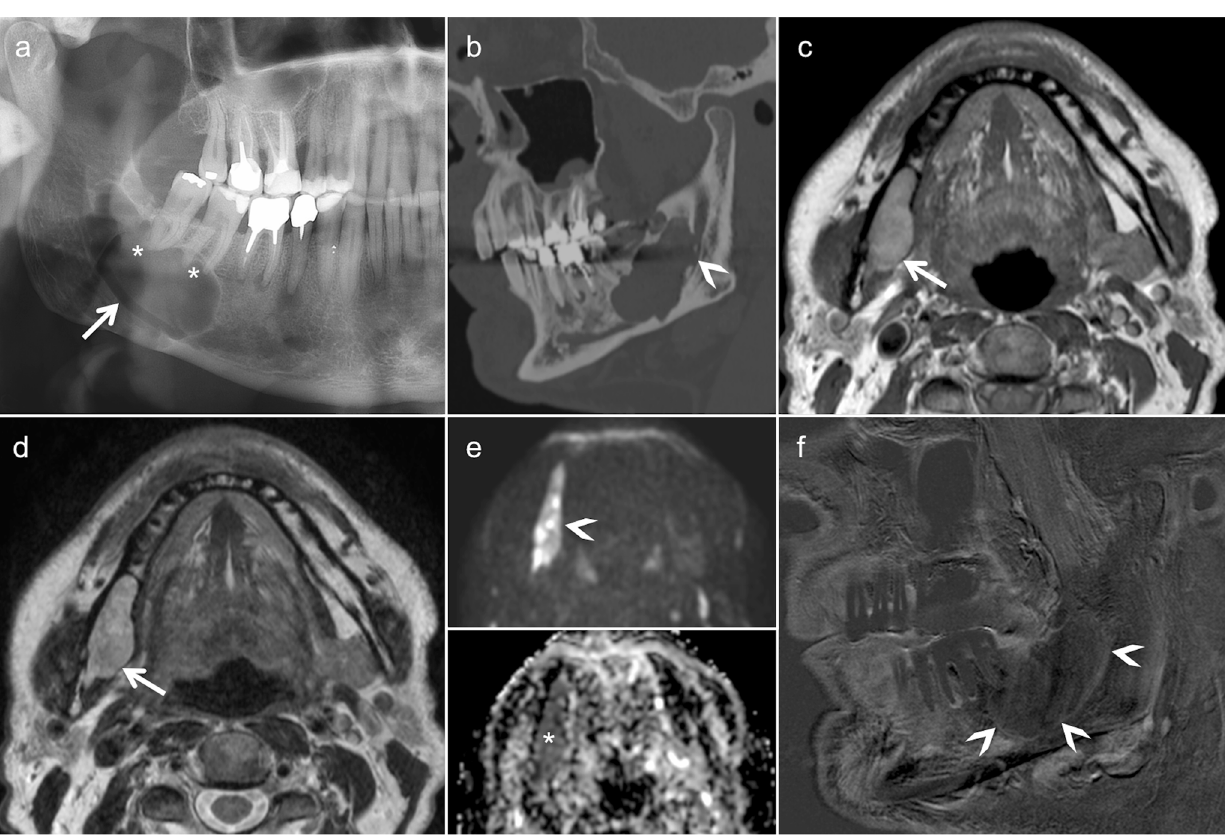
Fig. 5 Characteristic radiological findings of odontogenic keratocyst (OKC) as seen in an elderly male. a OPT shows a large, well-defined osteolytic lesion involving the body and angle of the mandible on the right encompassing the right inferior alveolar nerve canal ( arrow ). Absence of root resorption ( asterisks ). b Multiplanar reformatted CT image (bone window) shows an unilocular cystic expansile lesion extend- ing into the right inferior alveolar nerve canal ( arrowhead ). No periosteal reaction or pathological fracture. T1 ( c ) and T2 ( d ) axial images reveal